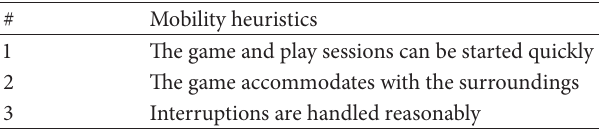
Table 8: The statements used in questionnaire to evaluate playabil-